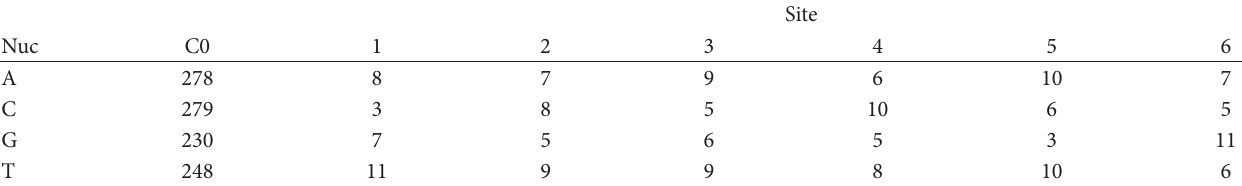
T2:Site-speci�cdistributionofnucleotidesfromthe29randommotifsoflength6.esecondcolumnliststhedistributionofnucleotides